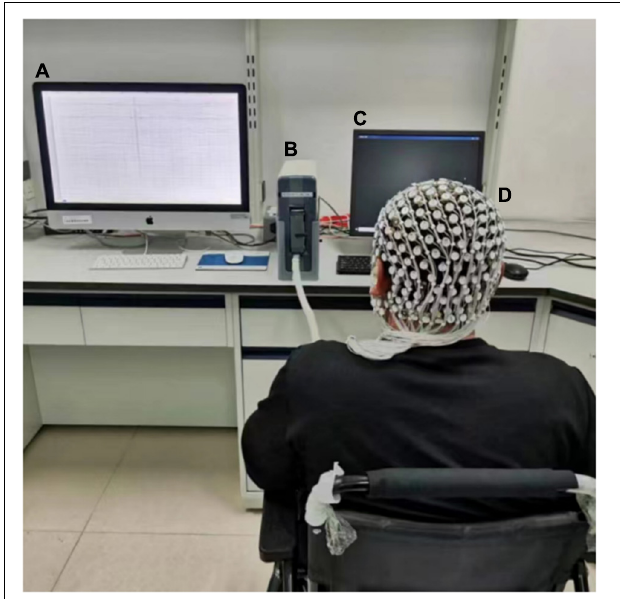
FIGURE 1 | Experimental setup. (A) Data acquisition; during EEG recording, this device maintained a black screen. (B) EEG Amplifier. (C) Monitor. (D) 256-electrode